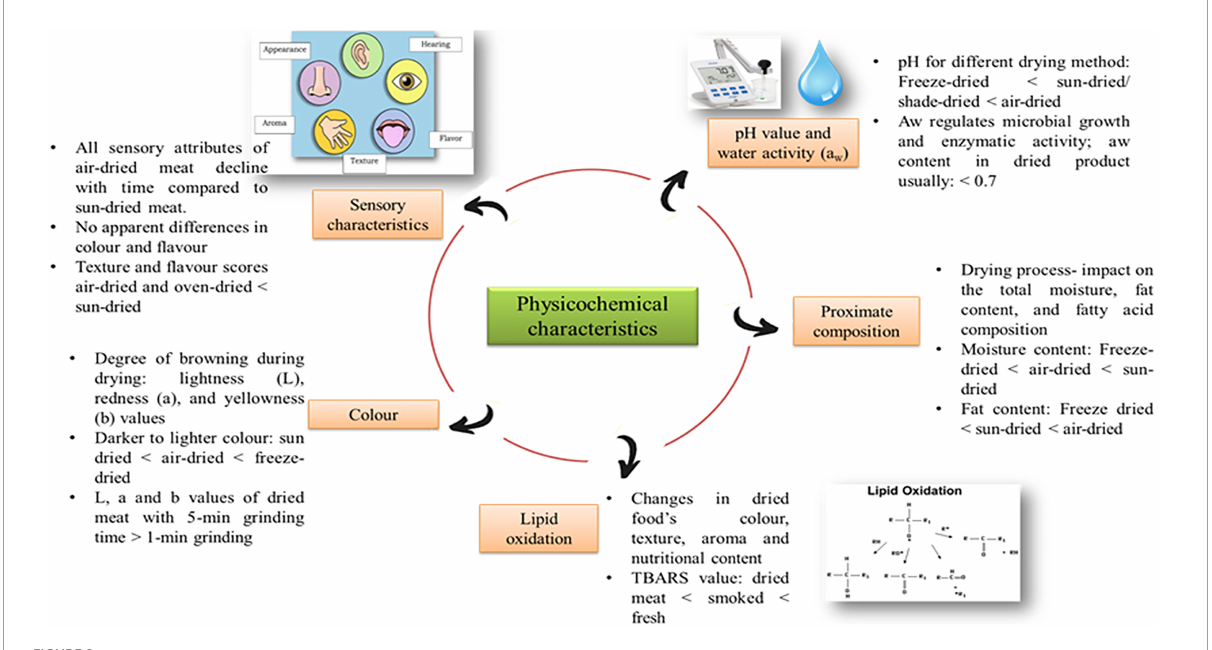
FIGURE2 The summary figure of physicochemical characteristics of dried meat and meat products.